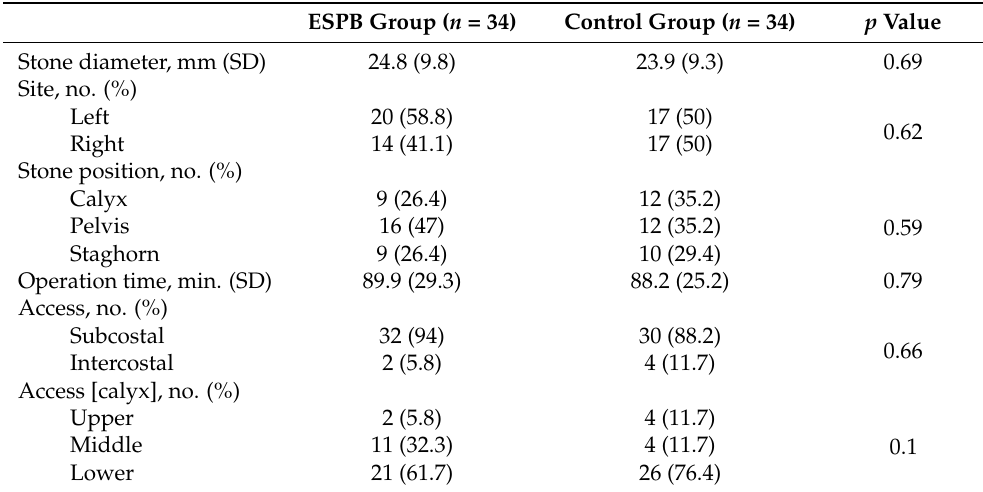
Table 2. Perioperative characteristics of the analyzed groups.